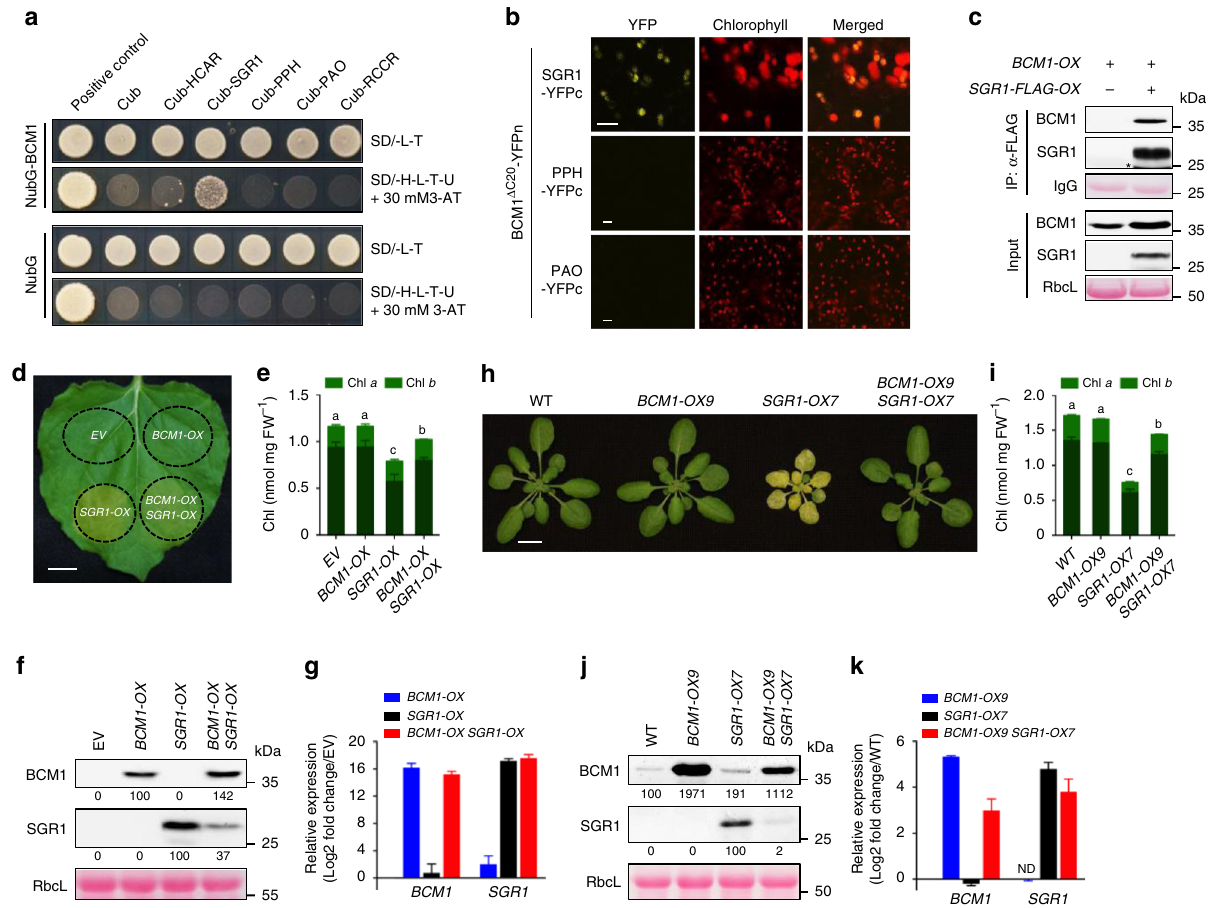
Fig. 7 BCM1 physically interacts with and destabilizes SGR1. a Y2H analysis of interactions between BCM1 and CCEs. The transformed yeast strains were analyzed on selective medium (SD/-L-T or SD/-H-L-T-U in the presence of 30 mM 3-AT). b BiFC assays con fi rm the speci fi c interaction between BCM1 and SGR1. The combinations of BCM1 Δ C20 -nYFP with PPH/PAO-cYFP were used as negative controls. Scale bars, 10 μ m. c Co-immunoprecipitation experiments demonstrate that BCM1 directly interacts with SGR1 in vivo. Anti-FLAG beads were used for immunoprecipitation. Samples of input and precipitated products were analyzed by immunoblot using anti-BCM1 and anti-SGR1 antibodies. d Representative image of a N. benthamiana leaf with zones overexpressing the empty vector (EV), BCM1 , SGR1 , and both BCM1 and SGR1 after 2 days of growth in the dark. The in fi ltrated leaf areas are indicated by circles. Scale bar, 1 cm. e Levels of Chl in the in fi ltrated leaf areas in d . f Steady-state levels of BCM1 and SGR1 in the in fi ltrated leaf areas in d were determined by immunoblotting using the indicated antibodies. g qRT-PCR analysis of BCM1 and SGR1 transcripts, con fi rming overexpression of these genes in the in fi ltrated leaf areas in d . Expression levels are presented relative to those in EV. h Representative image of 28-day-old WT, BCM1-OX9 , SGR1-OX7 , and BCM1-OX9 SGR1-OX7 seedlings grown under short-day normal light (120 μ mol photon m − 2 s − 1 ) conditions. Scale bar, 1 cm. i Levels of Chl in the seedlings shown in h . j Steady-state levels of BCM1 and SGR1 in the seedlings shown in h were determined by immunoblotting using the indicated